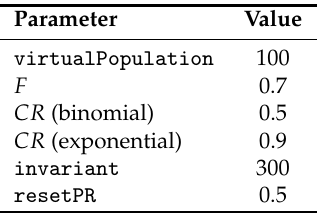
Table A2. Parameter settings for the cGA applied to the continuous OneMax